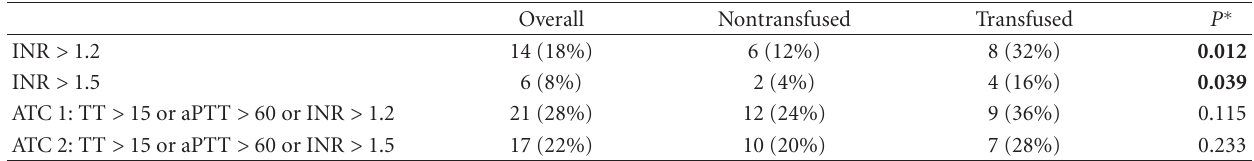
Table 2: Patients demonstrating criteria for acute traumatic coagulopathy in overall group, nontransfused and transfused patients. Overall Nontransfused Transfused P ∗ INR > 1.2 14 (18%) 6 (12%) 8 (32%) 0.012 INR >